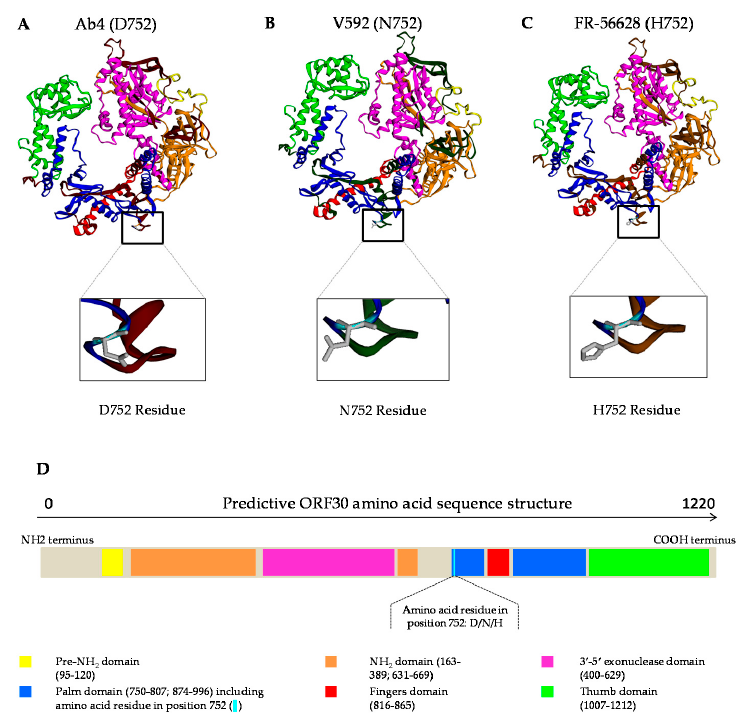
Figure 5. Three-dimensional models of EHV-1 strains Ab4 (D 752 ) ( A ), V592 (N 752 ) ( B ) and the newly isolated EHV-1 strain FR-56628 (H 752 ) ( C ). ORF30 amino acid sequences based on their homology with HSV-1 DNA polymerase and predictive structure of the ORF30 amino acid sequence ( D